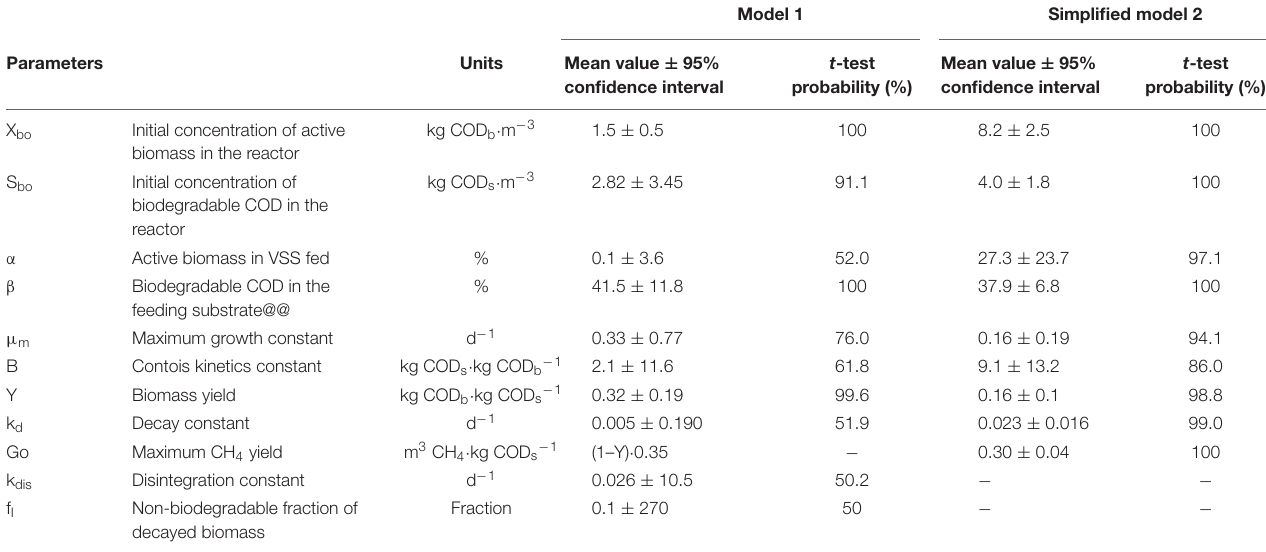
FIGURE 2 | Time evolution of the methane production rate and of VSS and tCOD in the reactor effluent during CSTR operation at the indicated average organics loading rate (OLR) values and the estimated values using model 1 ( Table 4 ) and the simplified model 2. See parameter values in Table 5 . TABLE 5 | Estimated parameter values for the models applied to CSTR